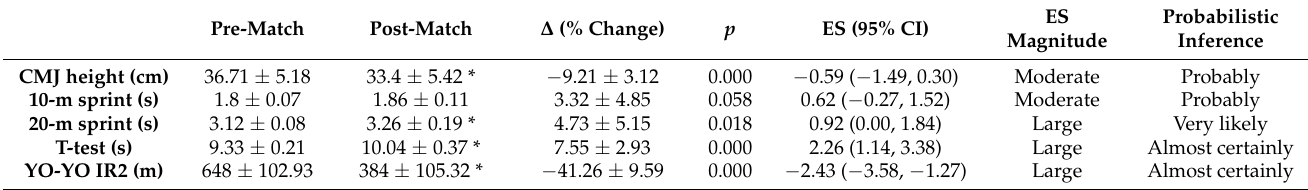
Table 2. Mean differences, standardized differences and qualitative probabilistic mechanistic infer- ence of neuromuscular performance and intermittent-running endurance capacity.